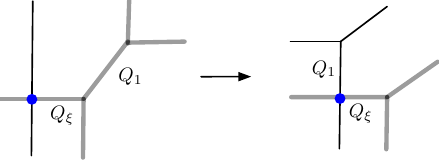
Figure 18 . Brane webs describe the theory U(1) 0 + 1 F + 1 AF with k eff = 0 + (1 − 1) / 2 = 0